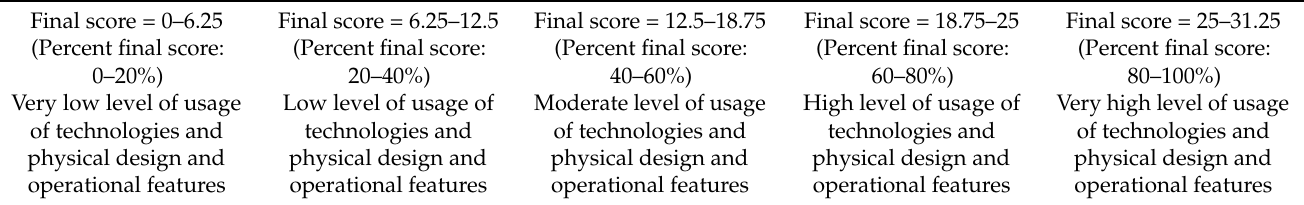
Table 1. Level of usage of enabling technologies and physical design and operational feature breakdown for HIRS survey. Final score = 0–6.25